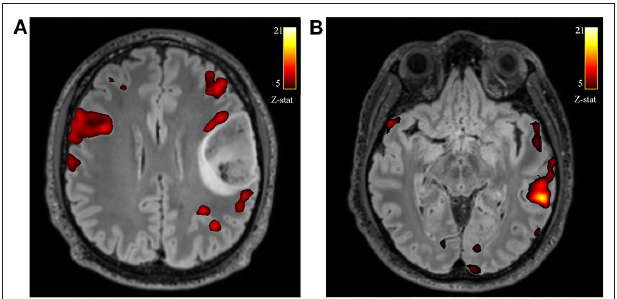
FIGURE 2 | Axial views of the T2-w FLAIR image superimposed the fMRI phonemic fluency fMRI activation. Example of one patient with left frontal glioblastoma grade 4, showing the recruitment of contralateral compensatory activation of right frontal operculum (A) and canonical temporal activation on the left hemisphere (B)